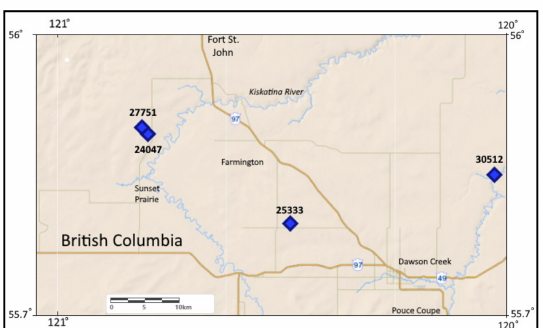
Figure 2. Map showing the location of the studied wells, Montney Formation, NE